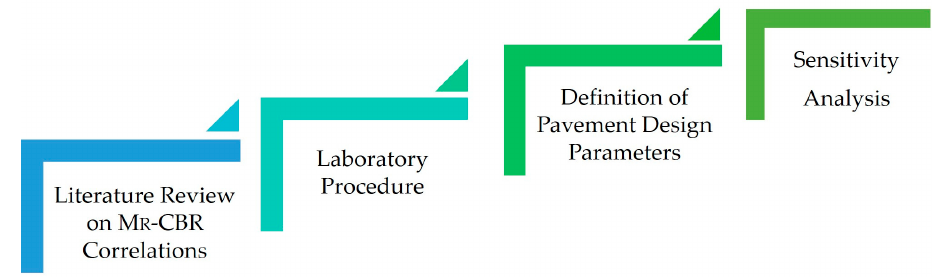
Figure 1. Research Figure 1. Research methodology.